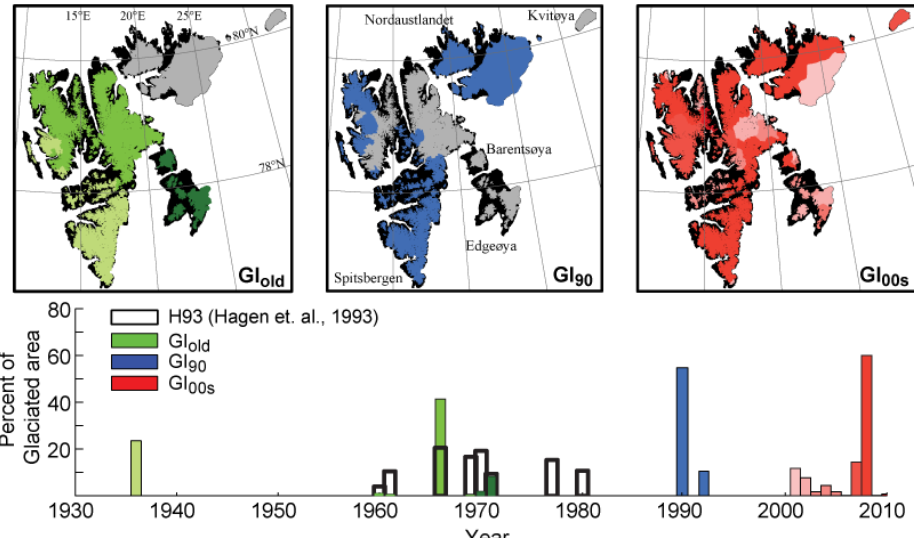
Fig. 1. Spatial and temporal coverage of glacier inventories (GI). The three maps (top) and the filled bars (bottom) show digitally available outlines. The black unfilled bars are the H93 tabular inventory (Hagen et al., 1993). The satellite-based inventory, GI 00s (in red), is the first digital inventory covering the entire archipelago. The shades of individual colors in the maps represent time within each inventory. Lighter shades are earlier; i.e. the lightest green is from 1936 and the lightest red from 2001. Grey represents no